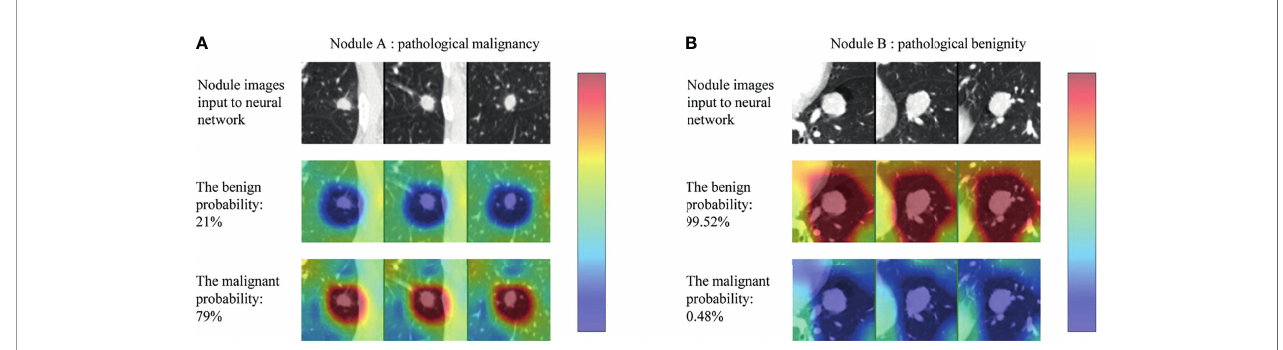
FIGURE 5 | Class activation map (CAM) for two example nodules (nodule A and B ) in the test set. For each nodule, the fi rst row (nodule images input to neural network) represented the three views of each nodule, the second (the benign probability) and third row (the malignant probability) represented the corresponding response heatmaps when the model classi fi es the nodule as benign and malignant, respectively (red regions are of highest interest and